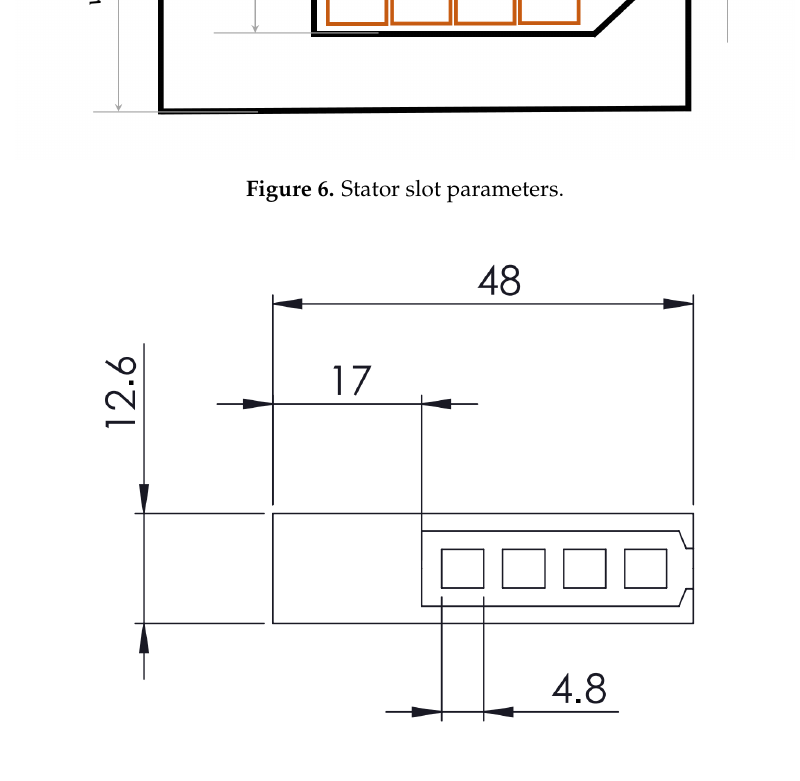
Figure 7. Rectangular slot, reference main dimensions in